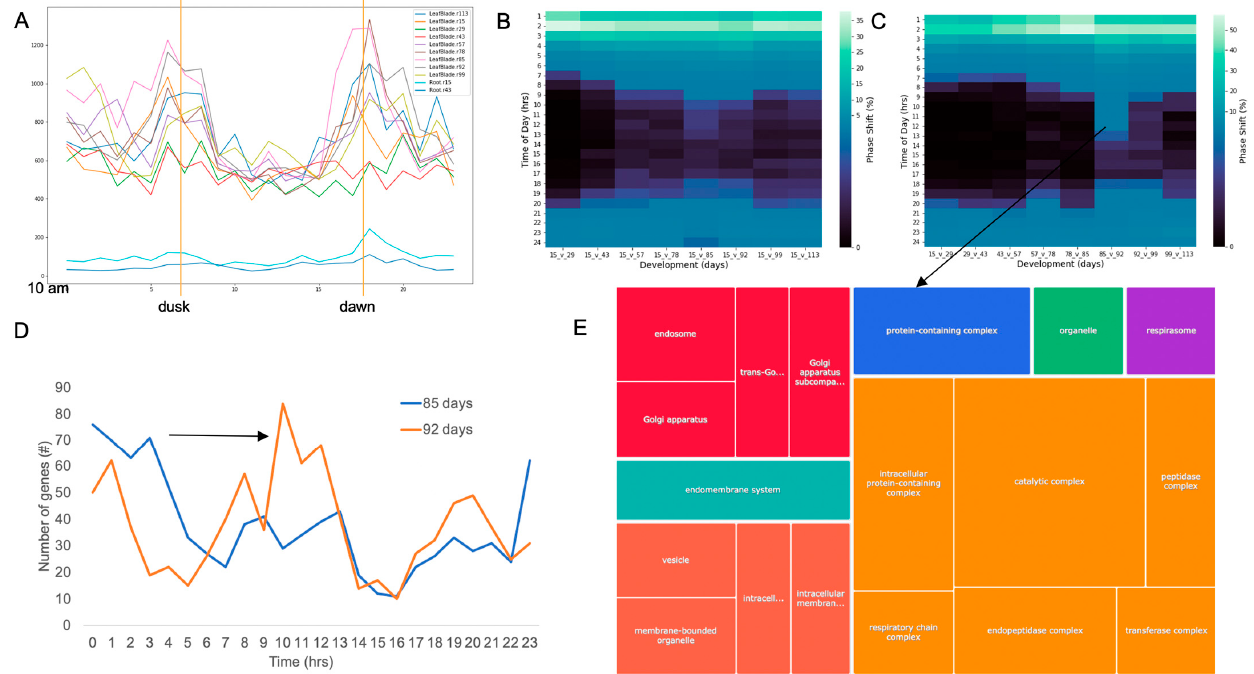
Figure 2. Global phase shifts associated with developmental timing. ( A ) Number of genes with specific time of day (TOD) expression across the eleven time courses. The time courses all started at 10 am, so relative dusk and dawn were marked; ( B ) relative phase shift compared to the first time course at 15 d with hrs shifted on the y -axis and the comparison time courses on the x -axis; ( C ) incremental phase shift comparing each proximal time courses with hrs shifted on the y -axis and the comparison time courses on the x -axis; ( D ) The phase shift of the genes from the incremental phase analysis between 85 and 92 d that showed a predominant shift from afternoon to mid-evening expression; ( E ) The significant gene ontology (GO) terms for the genes displaying the phase shift from the incremental phase analysis between 85 and 92 d; colors are arbitrarily assigned to GO terms with similar